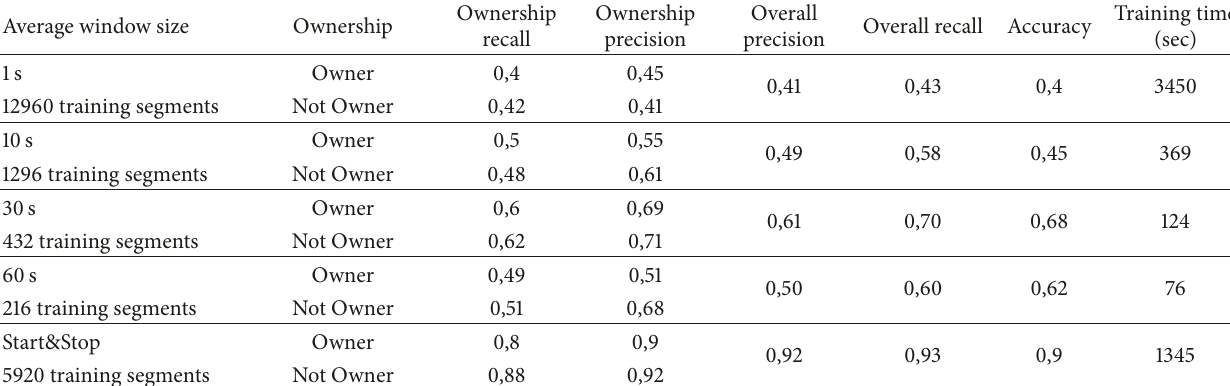
Table 11: 𝐸 32 , precision, recall, accuracy, and training time evaluated by using MLP for different windows sizes. Average window